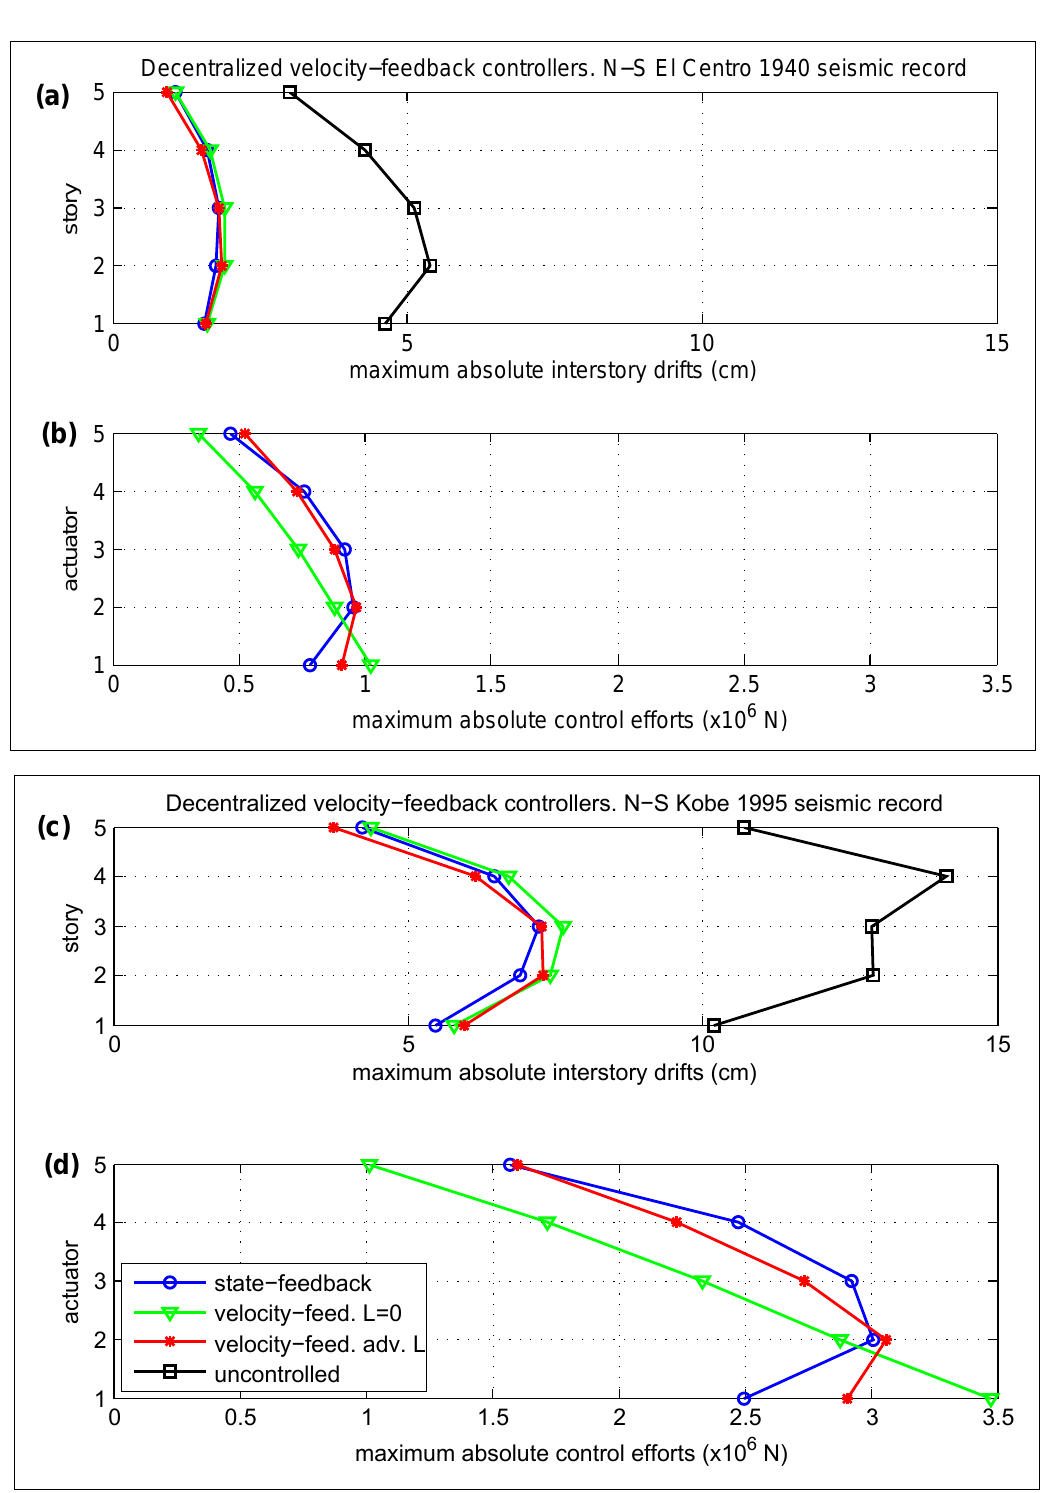
Figure 15: Maximum absolute interstory drifts and maximum absolute control efforts corresponding to the decentralized velocity-feedback controllers defined by the diagonal control gain matrices (cid:98) K ( d ) (green line with triangles) and (cid:101) K ( d ) (red line with asterisks). The plots corresponding to the uncontrolled building (black line with rectangles) and the optimal state-feedback H ∞ controller (blue line with circles) are also included as a reference. The full scale North–South El Centro 1940 seismic record has been used as ground acceleration input to obtain the plots in Figs. (a) and (b). For the plots in Figs. (c) and (d), the full scale North–South Kobe 1995 seismic record has been taken as